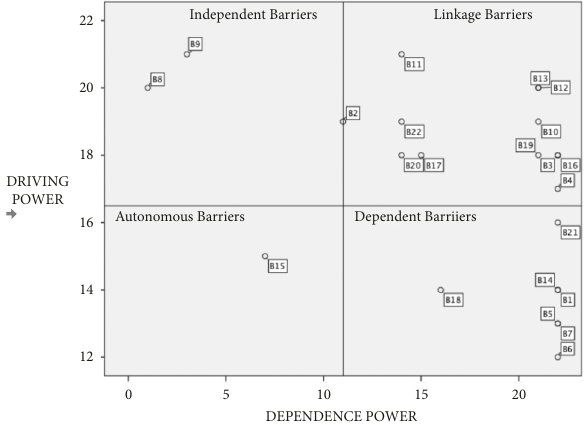
Figure 2: Driving power and dependence power